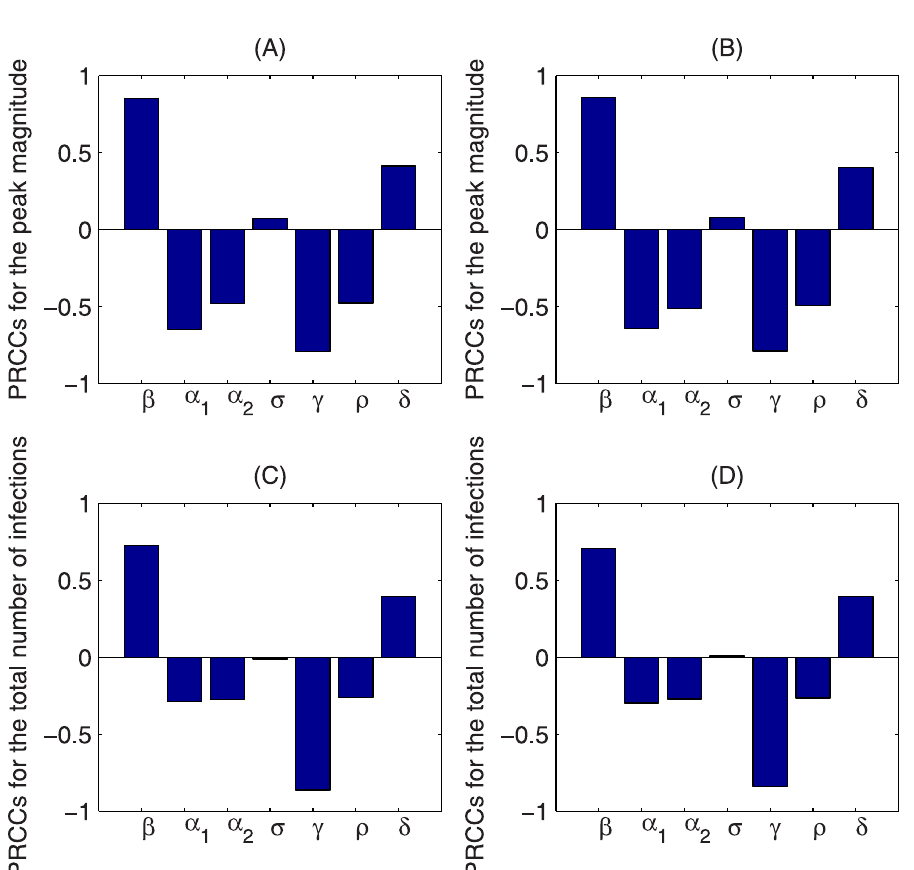
Fig 6. Sensitivity analysis. LHS-PRCC results for peak magnitude of infected individuals and total number of infections of system (1) with respective to β , α 1 , α 2 , σ , γ , ρ , δ . The sensitivity analysis is done with 2000 bins, the left and right columns correspond to system (1) with media functions f 1 and f 2 ,